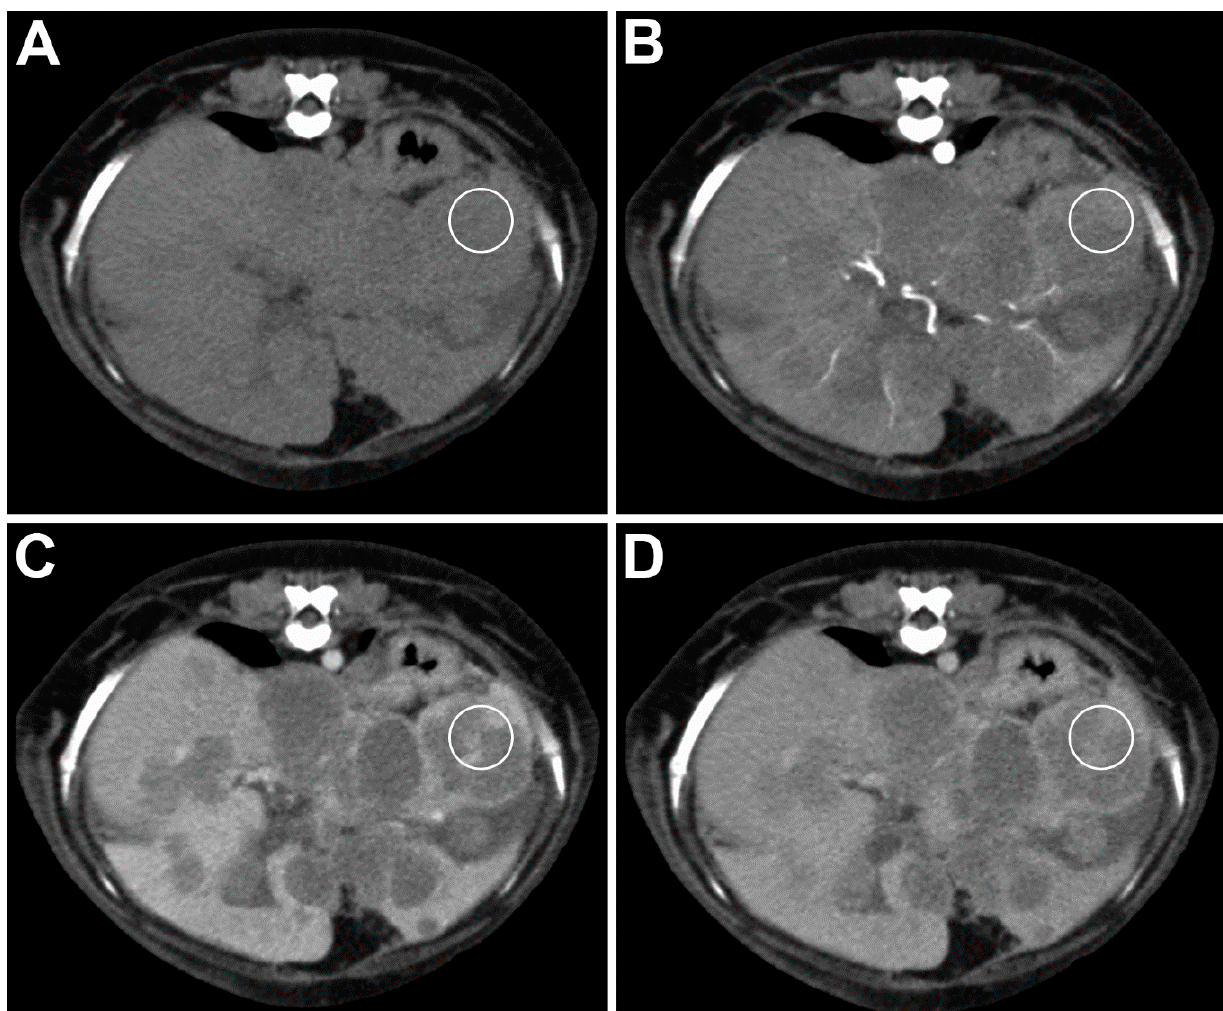
Figure 2. Transverse plane images of a TP-MDCT in a dog with HCC. ( A ) The lesions are isoattenuating in the pre-contrast phase. ( B ) Most of the lesions are isoattenuating in the arterial phase, and some are hypoattenuating. ( C ) The lesions are hypoattenuating in the portal phase. ( D ) In the delayed phase, some of the lesions are isoattenuating, and some are slightly hypoattenuating. The white circle shows the location of the ROI used for the measurement.